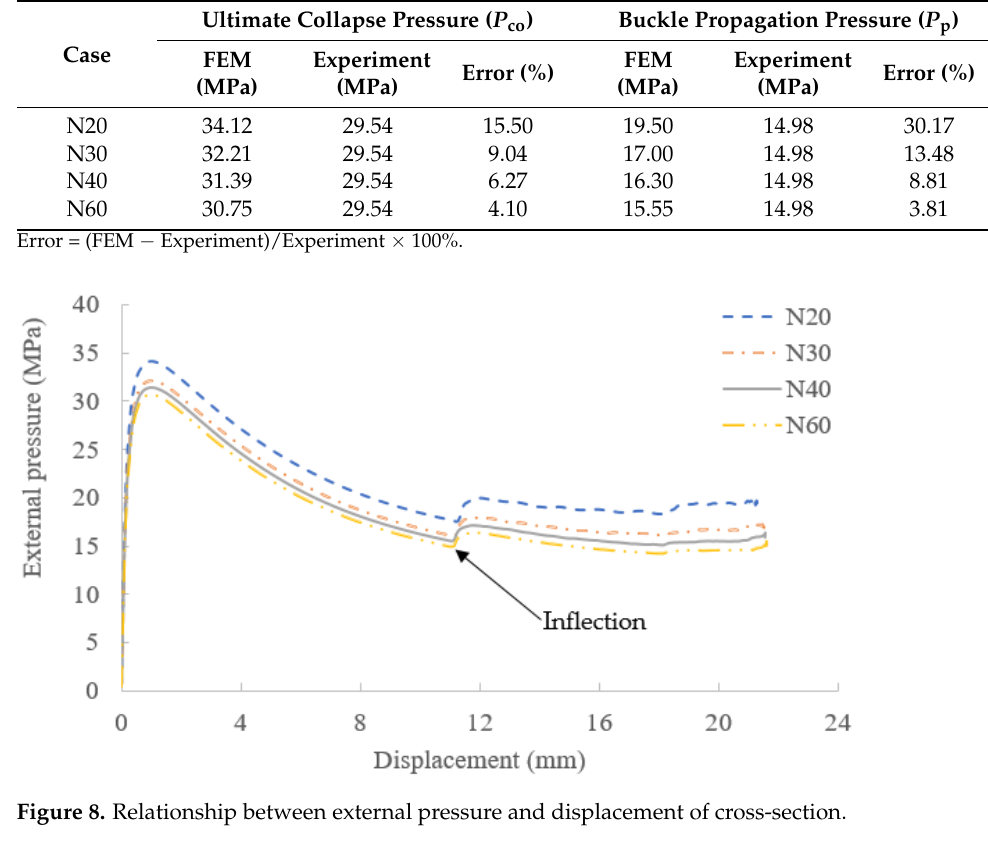
Table 3. Comparison results between N-series and experiment.